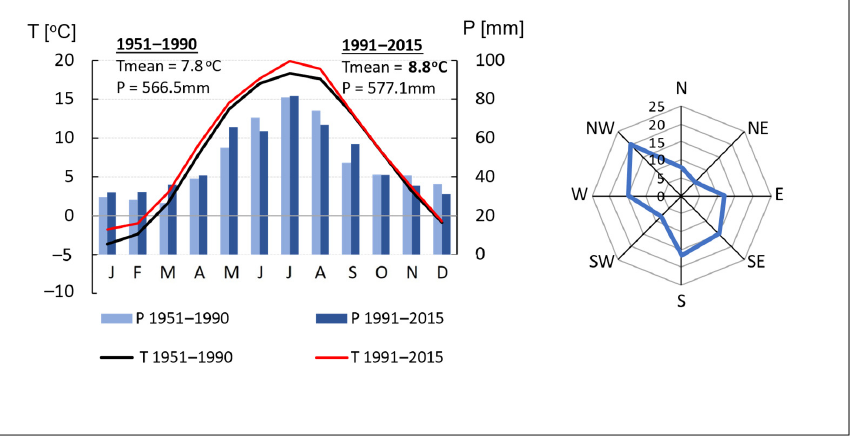
Figure 3. Climate diagram and wind rose for study area, constructed on the basis of data from meteorological station in Puławy for the years 1951–2015.